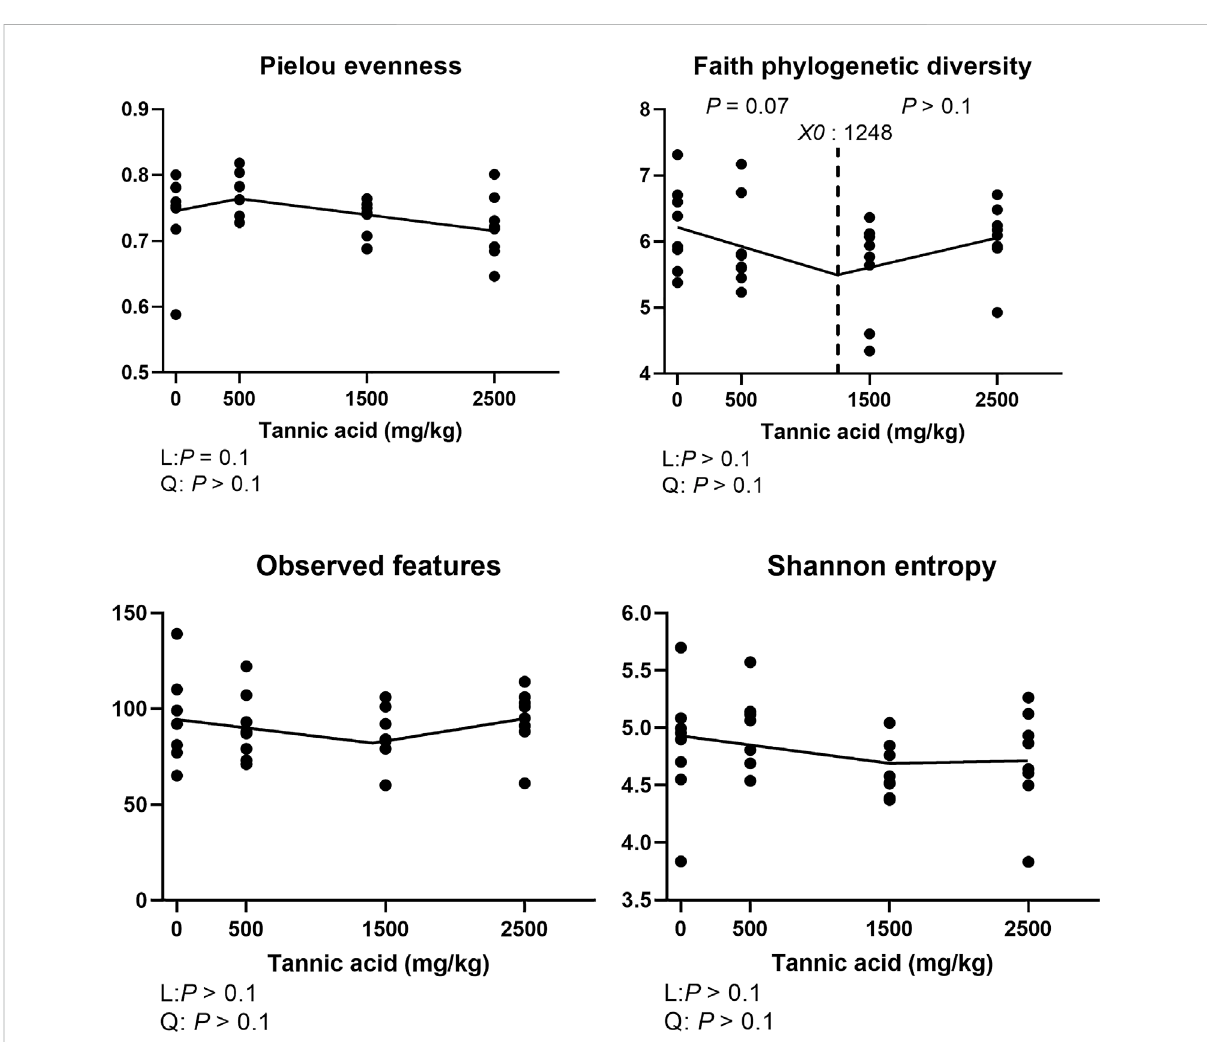
FIGURE 10 Alpha diversity indices of the cecal microbial communities in broiler chickens fed different concentrations (0, 0.5, 1.5, and 2.5 g/kg) of tannic acid on D 21. The treatment groups were compared using one-way ANOVA followed by the Tukey ’ s multiple comparison. Different superscripts differ at p < 0.05. Orthogonal polynomial contrasts analysis was conducted to see linear pattern (L) and quadraticpattern (Q) among the treatments. Tocalculatetheoptimaldosageoftannicacidinbroilers,segmentedlinearregressionwasconducted,and X0 (in fl ectionpoint)with p valuesfor slope 1 (lower than X0 ) and slope 2 (higher X0) were